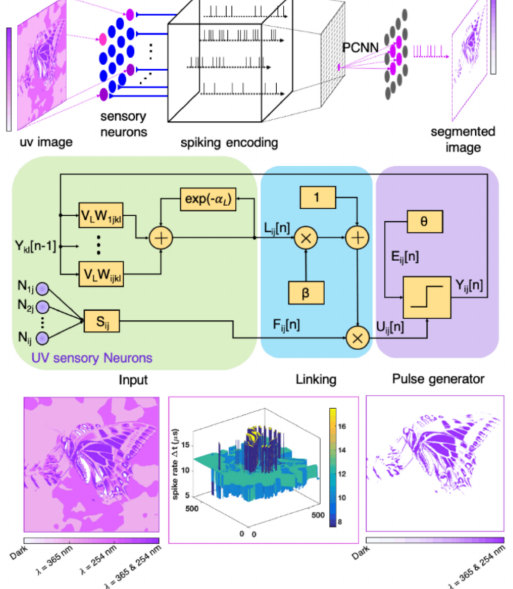
Figure 18. Impulse coupled neural network based on